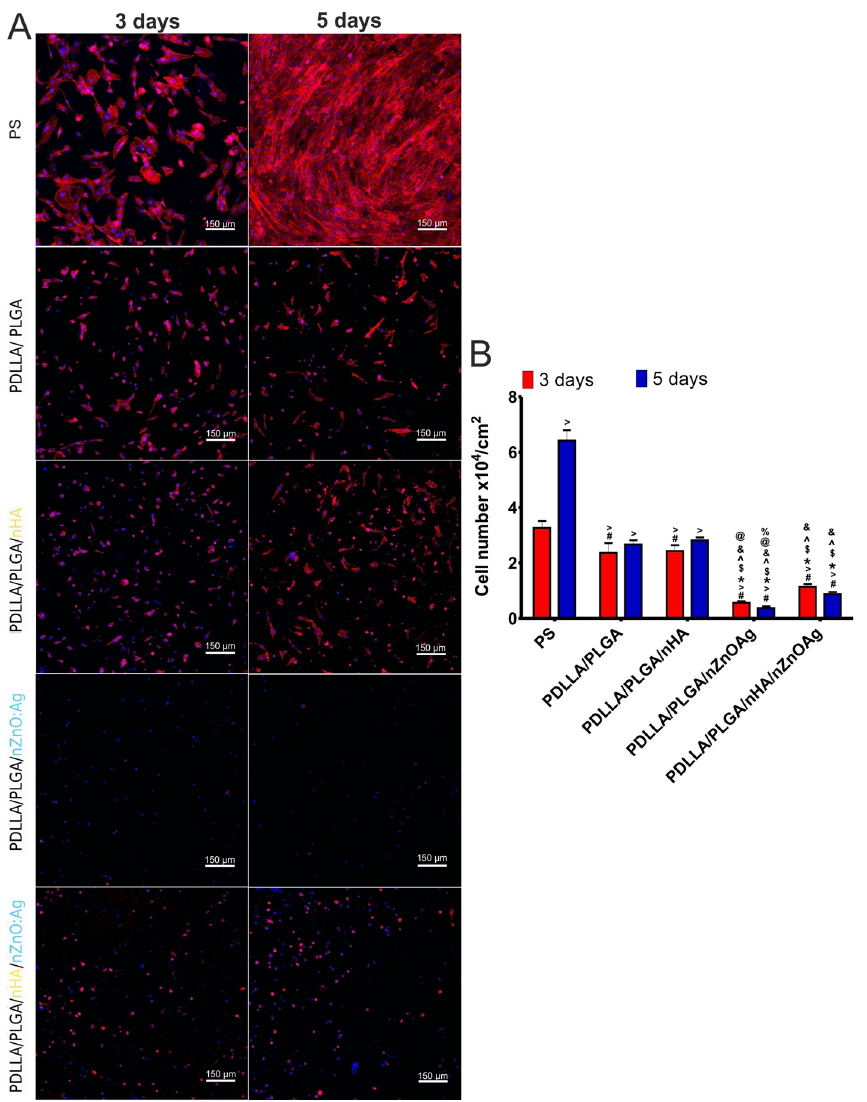
Figure 10. Confocal microscope images of ( A ) the morphology of normal human fetal osteoblasts (hFOB 1.19 cell line, ATCC CRL ‐ 11372 TM ) after 3 and 5 days of cell cultivation on investigated bio ‐ materials. The cells cultured on polystyrene (PS) were considered as a control in the experiment. Nuclei emitted blue fluorescence and cytoskeleton filaments red fluorescence. Magnification: 100×; scale bar: 150 μ m. ( B ) The number of cells was determined based on the obtained images. # p < 0.05 compared to PS at day 3; > p < 0.05 compared to PS at day 5; * p < 0.05 compared to PDLLA/PLGA at day 3; $ p < 0.05 compared to PDLLA/PLGA at day 5; ^ p < 0.05 compared to PDLLA/PLGA/nHA at day 3; & p < 0.05 compared to PDLLA/PLGA/nHA at day 5; @ p < 0.05 compared to PDLLA/PLGA/nHA/nZnO:Ag at day 3; % p < 0.05 compared to PDLLA/PLGA/nHA/nZnO:Ag at day 5; one-way ANOVA test followed by Tukey’s multiple